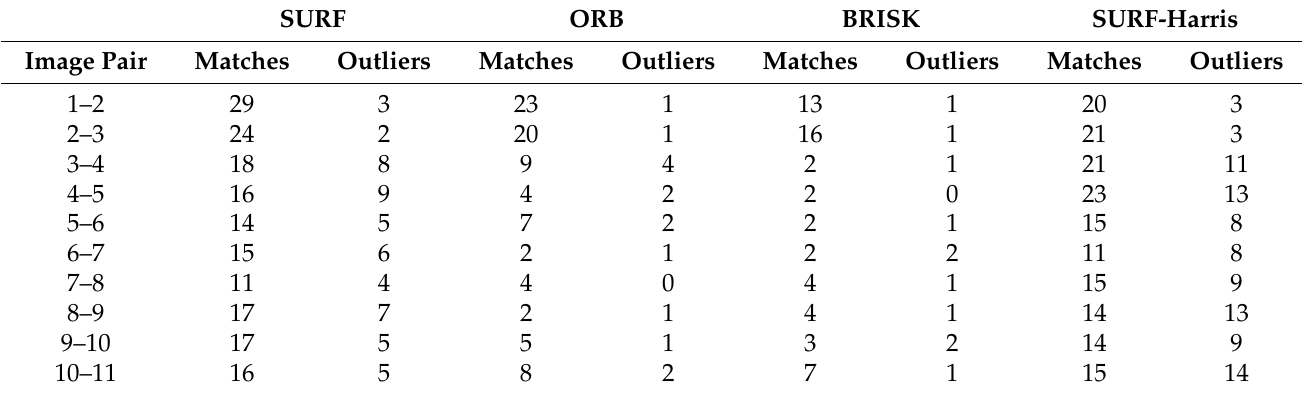
Table 6. Number of matches performed and corresponding number of outliers for dataset 2.